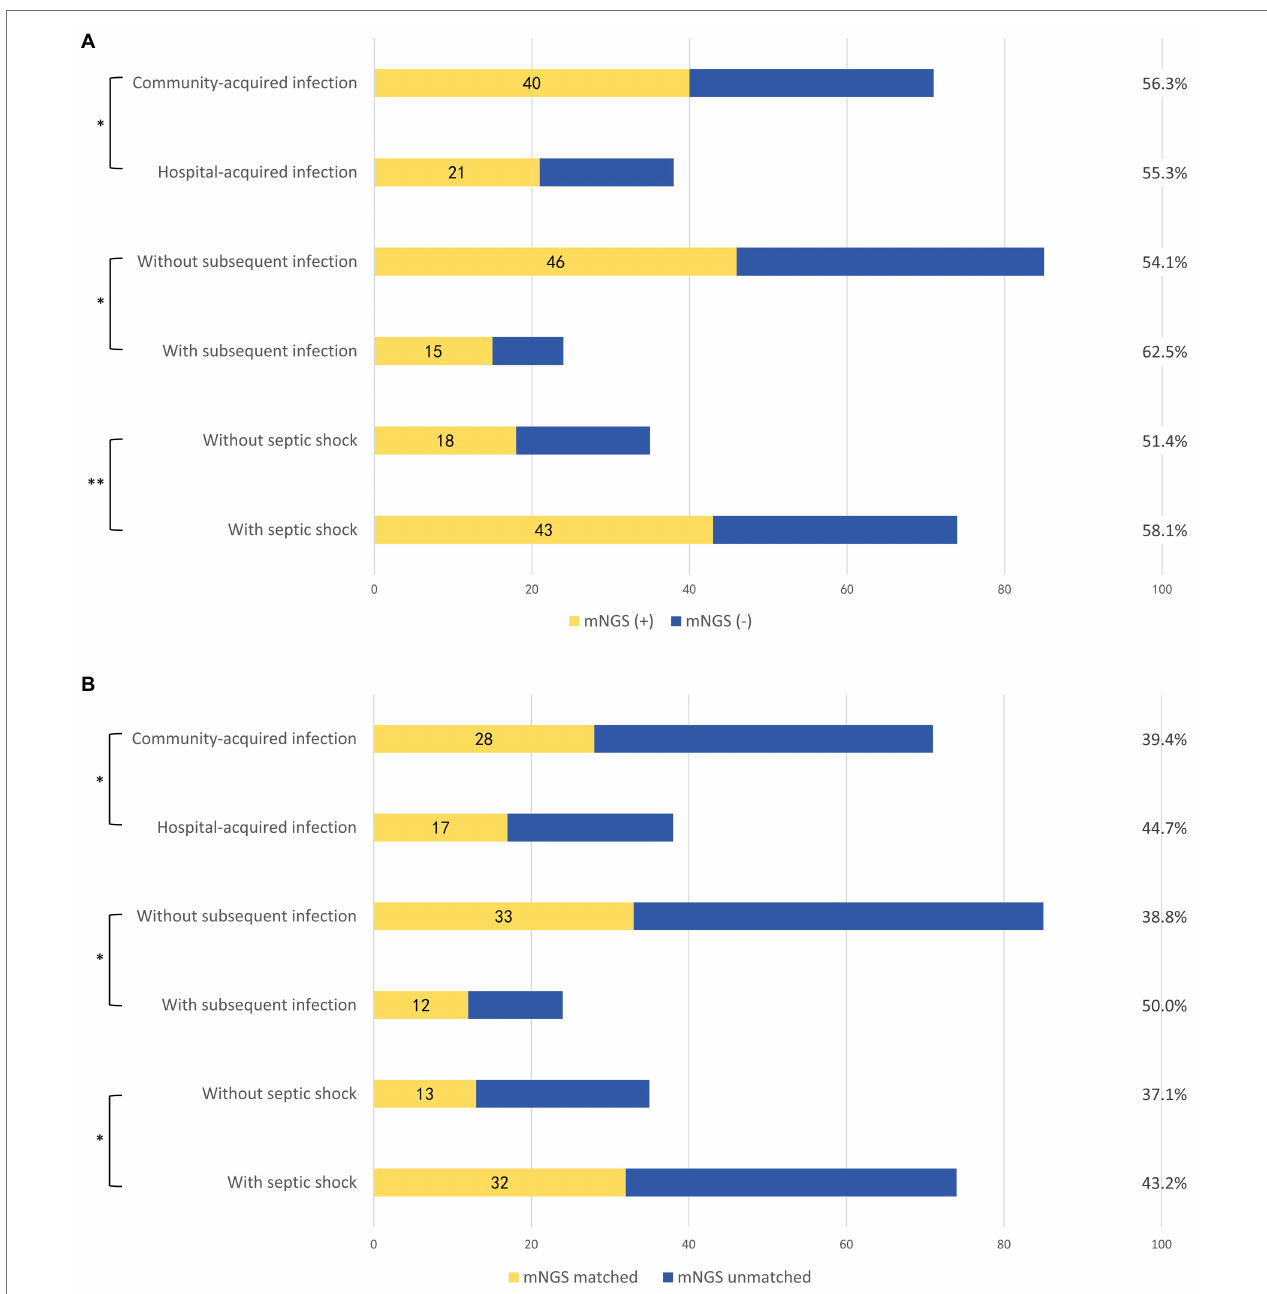
FIGURE 4 | Subgroup analysis according to different clinical scenarios. (A) Proportions of plasma mNGS positive samples in different clinical scenarios. (B) Concordance of the plasma mNGS detection and PD culture in different clinical scenarios. mNGS (+), positive detection in plasma mNGS method; mNGS ( − ), negative detection in plasma mNGS method; mNGS matched, the plasma mNGS detection partially or completely was in accord with the PD culture result; and mNGS unmatched, the plasma mNGS detection completely disaccord with the PD culture result. Subsequent infections included: subsequent bloodstream infection, surgical site infection/skin soft-tissue infection, and intestinal fistula. * p < 0.005 and ** p =